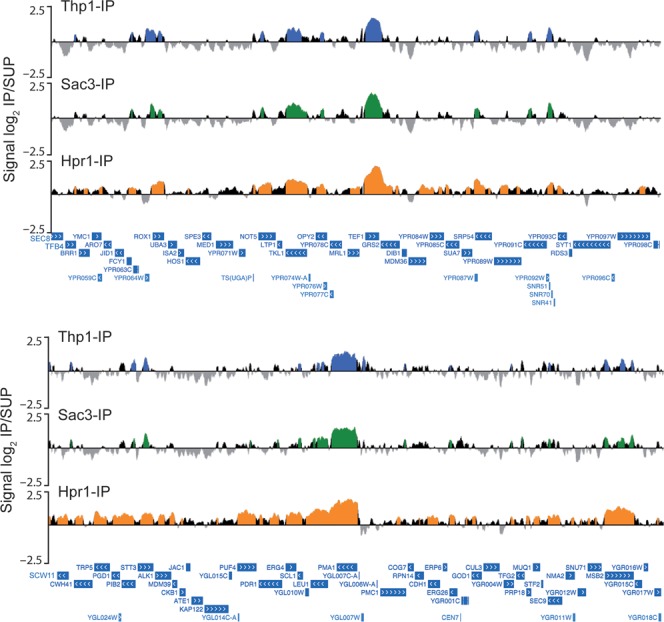
Recruitment pattern of Thp1, Sac3 and the THO complex to ORFs. ChIP-chip analysis of Thp1-FLAG, Sac3-FLAG and Hpr1-FLAG binding to the whole genome. Two genomic fragments from chromosomes XVI and VII are shown, with enrichment values represented as signal log2 IP/SUP ratio. Blue (Thp1-IP), green (Sac3-IP) and orange (Hpr1-IP) histograms (online version) represent the significant binding clusters (P < 0.01, minimum run >100 bp, maximum gap <250 bp). Genes and other features are represented according to the Saccharomyces Genome Database (SGD) as blue bars and white arrows in relation to the direction of transcription.